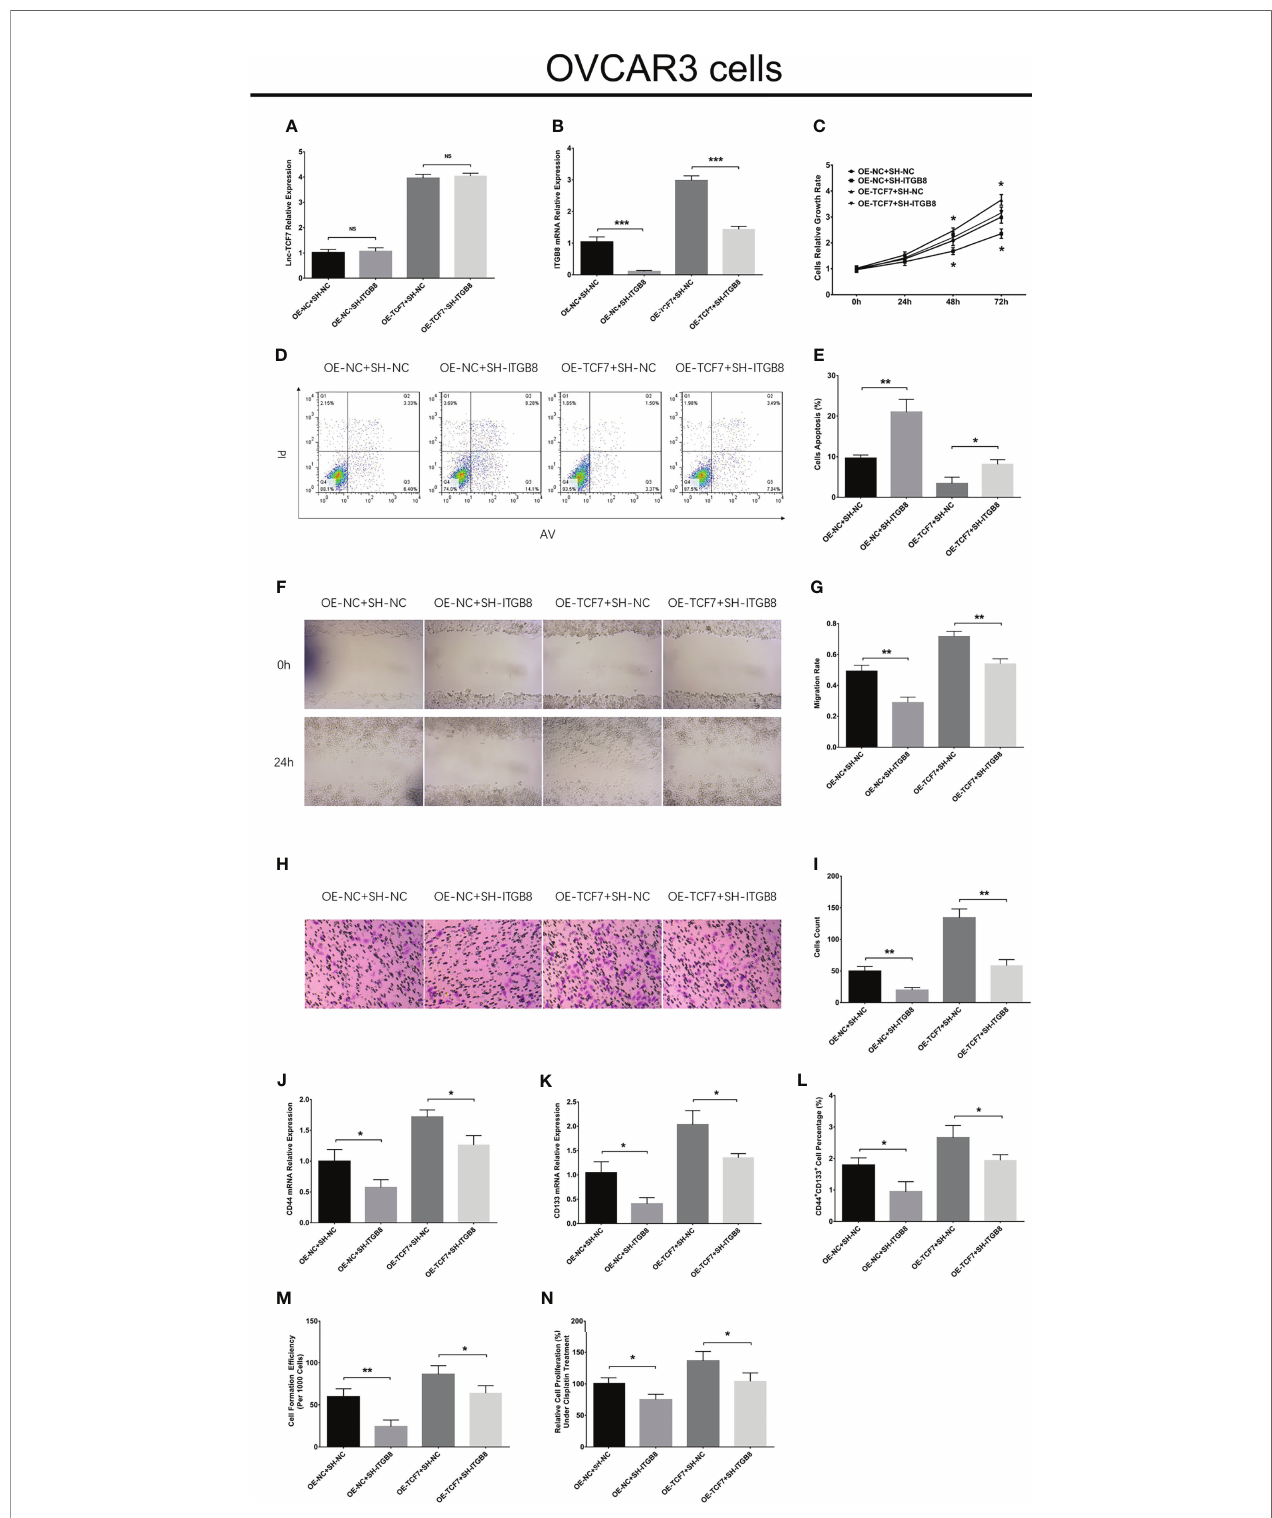
FIGURE 8 | Effect of ITGB8 knockdown on cell proliferation, apoptosis, migration, invasion, stemness and cisplatin sensitivity in OVCAR3 cells. Lnc-TCF7 expression (A) , ITGB8 expression (B) , cell proliferation (C) , cell apoptosis rate (D, E) , cell migration (F, G) , cell invasion (H, I) , CD44 expression (J) , CD133 expression (K) CD44 + CD133 + cell percentage (L) , spheres formation ef fi ciency (M) and cisplatin sensitivity (N) after corresponding transfections. Experiments were performed in triplicates. * represented P < 0.05, ** represented P < 0.01, *** represented P < 0.001, ns represented no signi fi